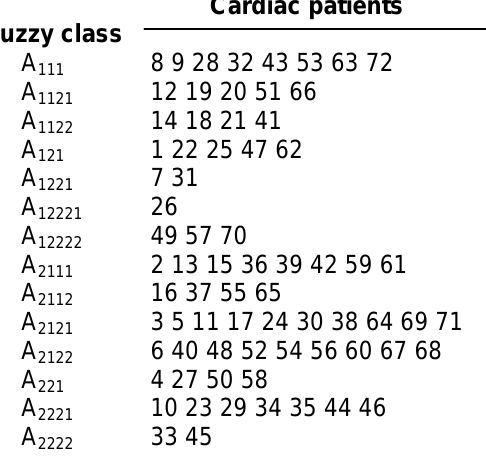
Final Fuzzy Partition of the Cardiac